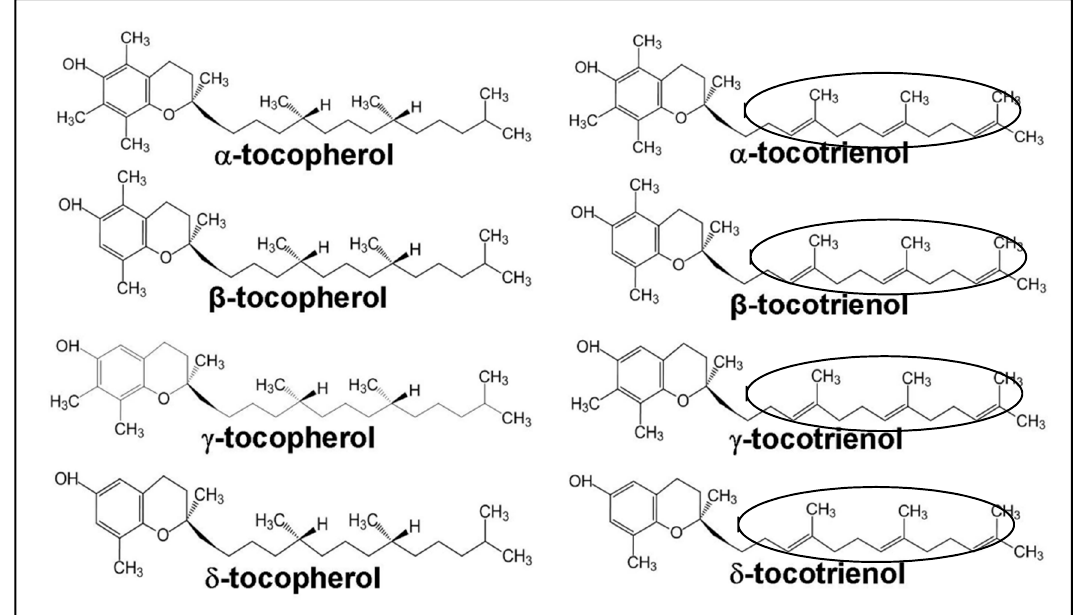
Figure 1. Structure differences between tocopherols (TOCs) and tocotrienols (TCTs). TOCs have saturated side chains, while TCTs have unsaturated side chains. The latter are shown by the presence of three double bonds in TCTs (circled) [14].